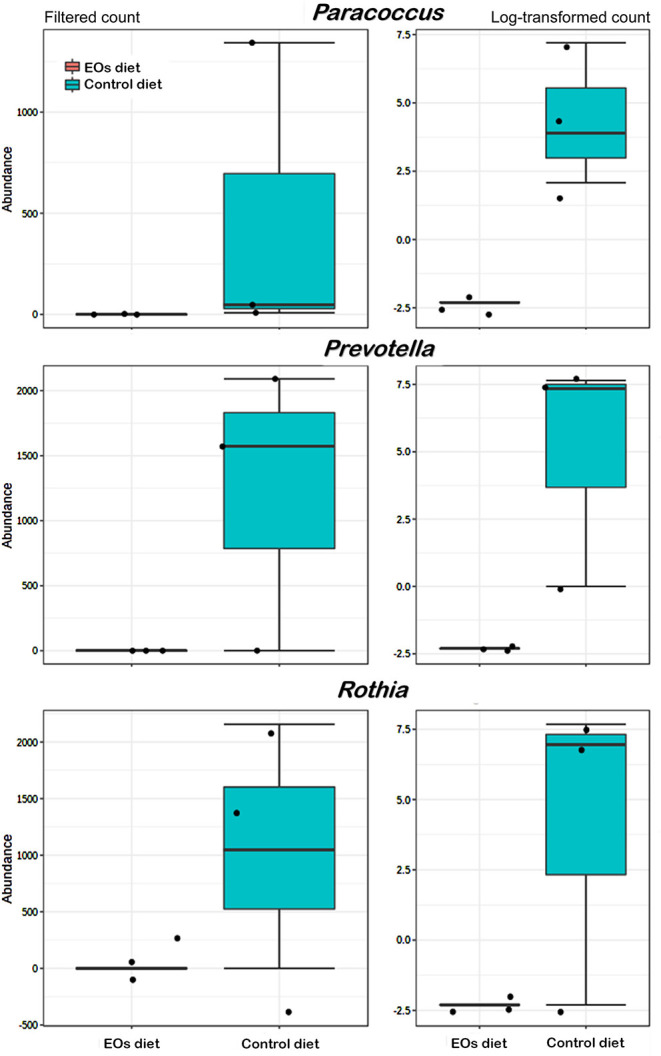
Average abundance of genera showing significant differences (p < 0.01) in the posterior intestine of gilthead seabream (S. aurata) fed the garlic, carvacrol, and thymol essential oils (EOs)-supplemented diet in comparison with fish receiving the control diet.